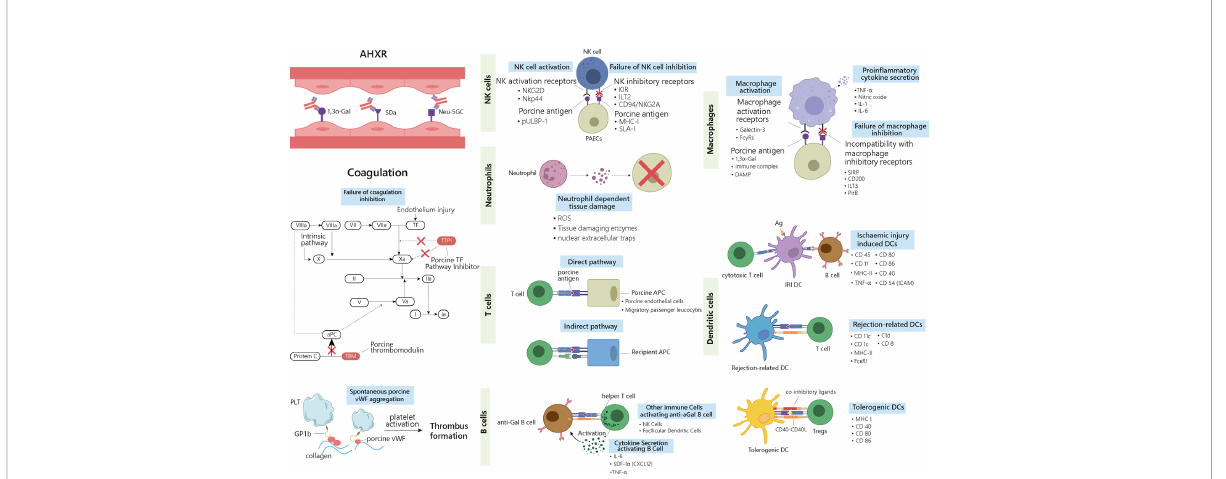
FIGURE 2 Delayed xenograftrejection: AHXR, cellular xenograftrejection and coagulation dysregulation. The antibodies involved in AHXR aremainly